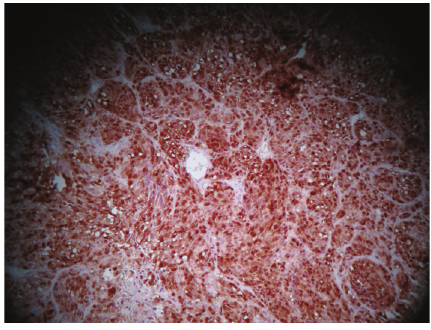
Figure 2: Tumor cells showing positive immunostaining to PS100 (HES ×